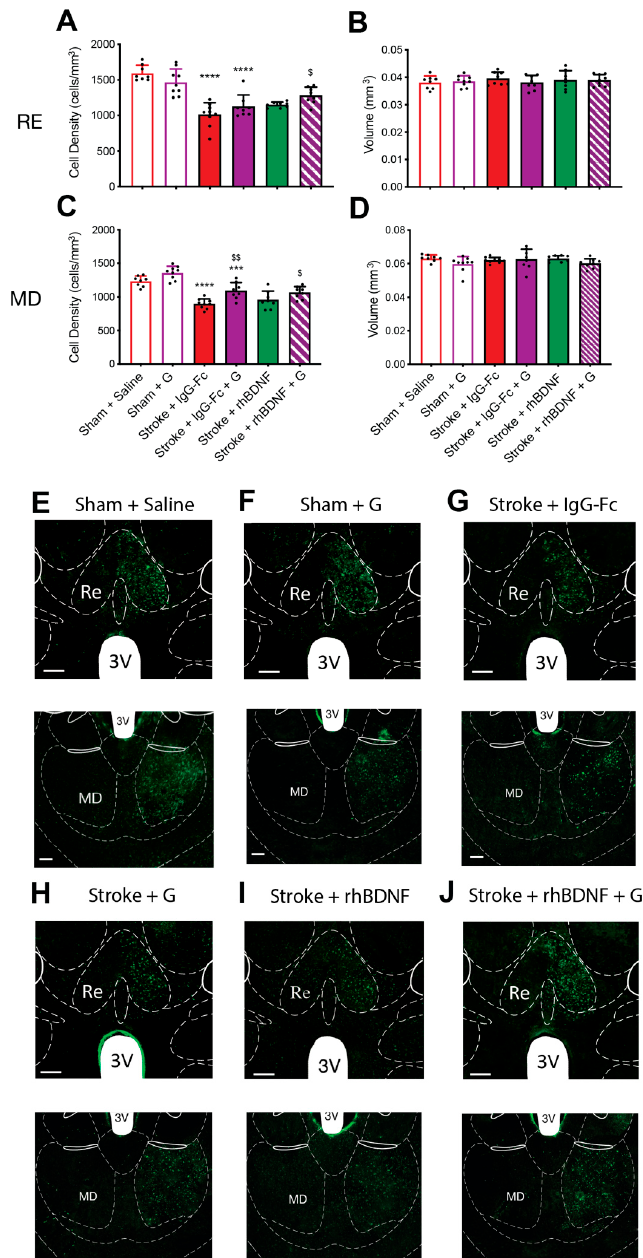
Figure 5. Effects of compound G treatment, with or without rhBDNF, on cholera toxin subunit B (CTB)+ve cell populations in the thalamus following PFC stroke. CTB+ve staining was quantified in the nucleus reuniens (RE, − 1.34 mm bregma) and mediodorsal thalamus (MD, − 1.34 mm bregma) at day-35 post-stroke. Stroke-caused a significant reduction in the density of CTB+ve cells in the RE ( A ) and MD thalamus ( C ) of animals treated with a vehicle (sham + saline, n = 8; stroke + IgG-Fc, n = 8) or compound G (sham, n = 9; stroke, n = 8). Compound G treatment significantly reduced the stroke-induced loss in the density of CTB+ve cells in the MD thalamus only. Further, the combinational treatment of compound G + rhBDNF ( n = 7) significantly dampened the stroke-induced loss of CTB+ve cell densities in the RE and MD thalamus, but to a similar extent as compound G treatment alone. Lastly, no difference was observed in the volume of the RE ( B ) or MD thalamus ( D ) across all animals. Representative images of both thalamic regions are shown in ( E – J ). Two-way ANOVA: *** p < 0.001, **** p < 0.0001, relative to sham counterpart; $$ p < 0.001, relative to vehicle-treated counterpart; one-way ANOVA: $ p < 0.05, relative to IgG-Fc. 3 V = third ventricle. Scale bar (white bar, bottom left) = 100 µ